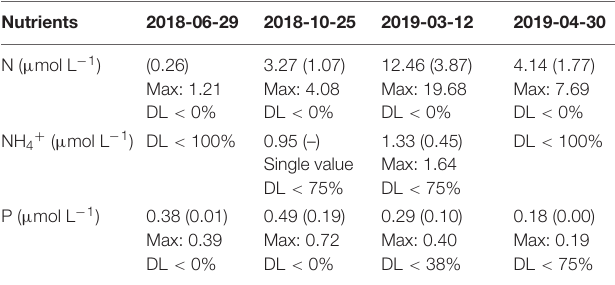
TABLE 3 | Nutrients per field campaign average, standard deviation, maximum, and percentage of samples above the DL of the method.